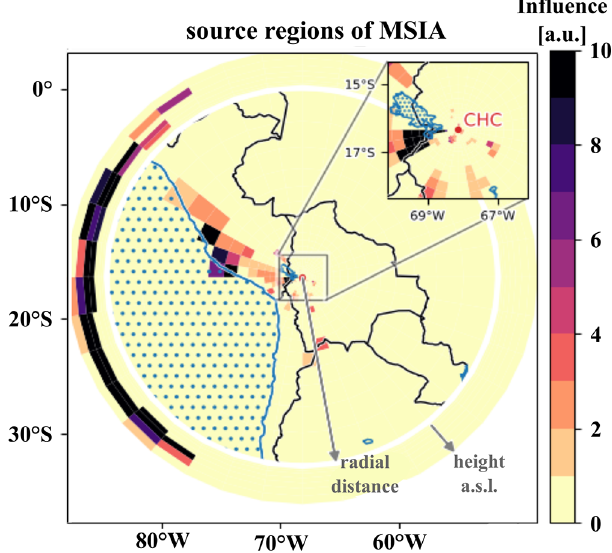
Figure 9. FLEXPART source regions determined using the MSIA time series, showing a strong impact of transport through the FLEX- PART domain lateral